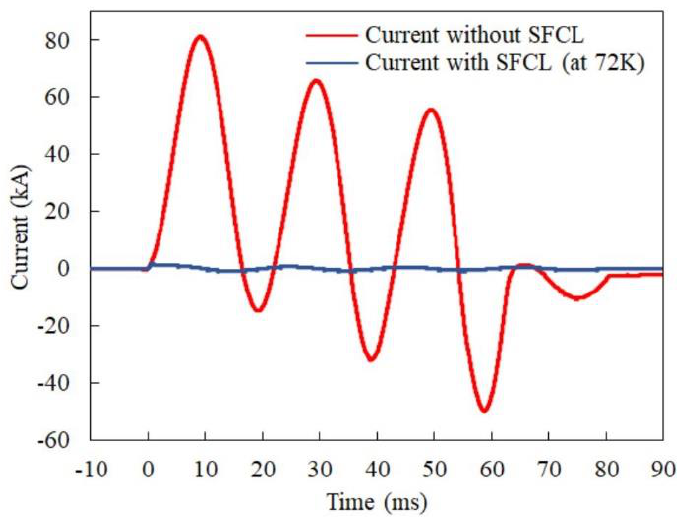
Figure 7. Voltage across the SFCL and current courses during short-circuit test at 80 K.